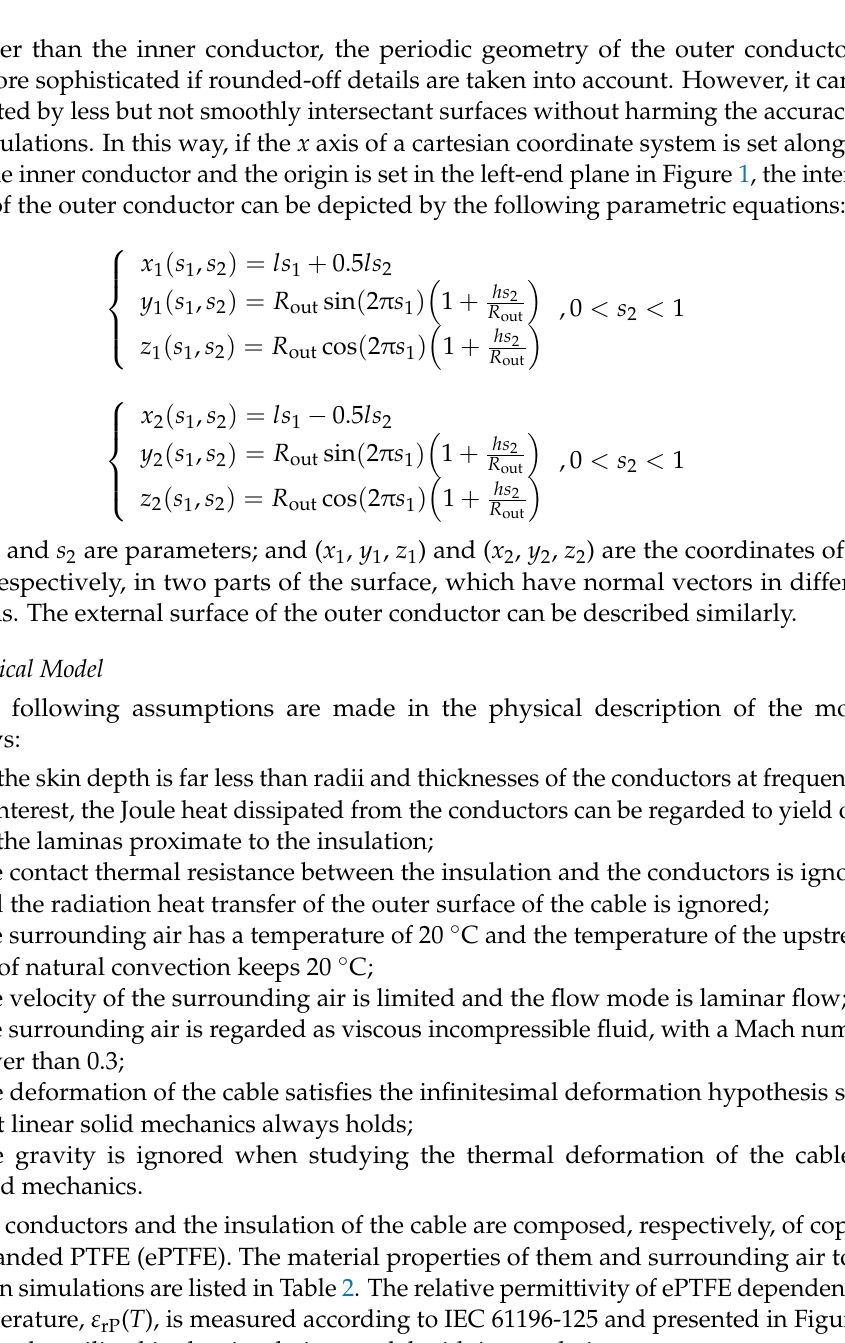
Table 1. Explanation of the notations in Figure 2. Notation Meaning Value R in Radius of the inner conductor 1.28 mm R out Minimum inside radius of the outer conductor 3.32 mm h Maximum difference of the outer conductor inside radius 0.3 mm l Pitch of the corrugation 3 mm t out Thickness of the outer conductor along the radial direction 0.3